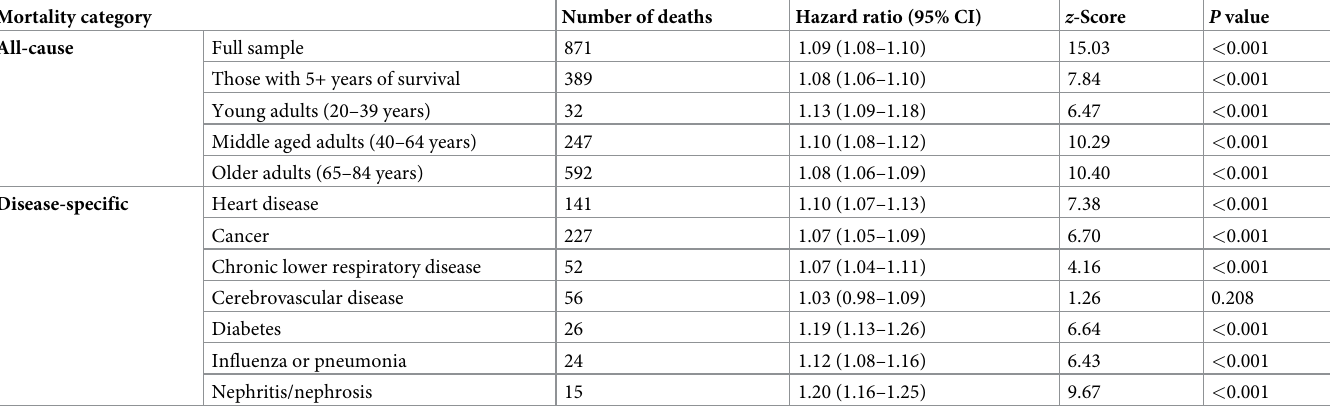
Table 1. Association of Phenotypic Age with all-cause mortality and disease-specific mortality.